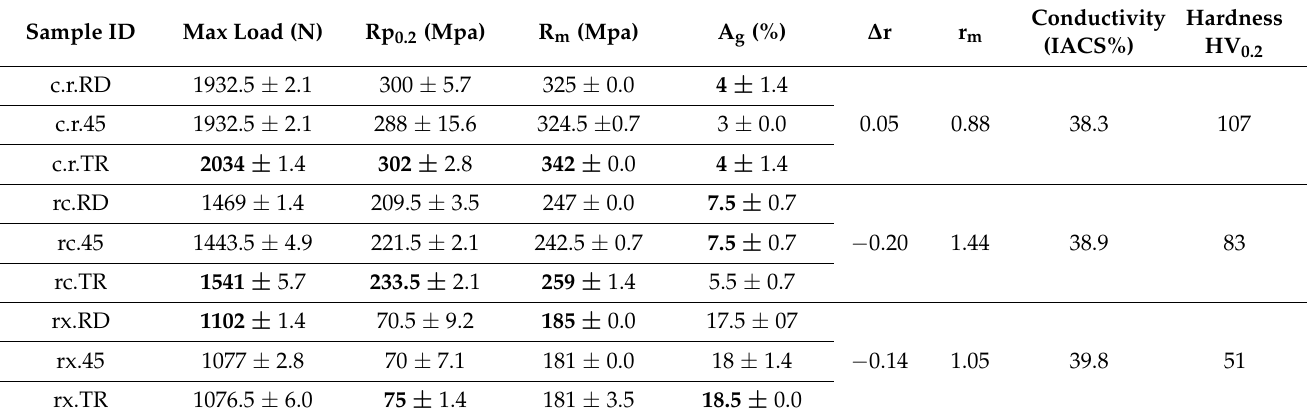
Table 2. Mechanical properties of the examined samples.